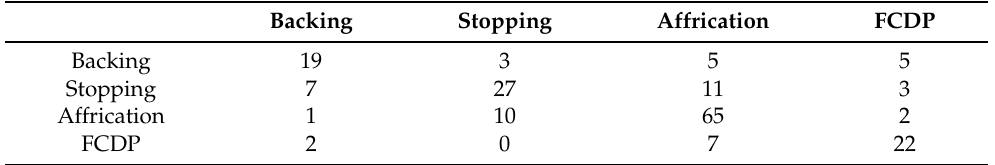
Figure 9. Validation accuracy of single Chinese character multi-category classification box plot (Experiment-3). Table 14 presents the results in detail. Table 13. One of the most effective confusion matrices in Experiment 3 when the InceptionV3 model was used. Rows indicate output classes, columns indicate target